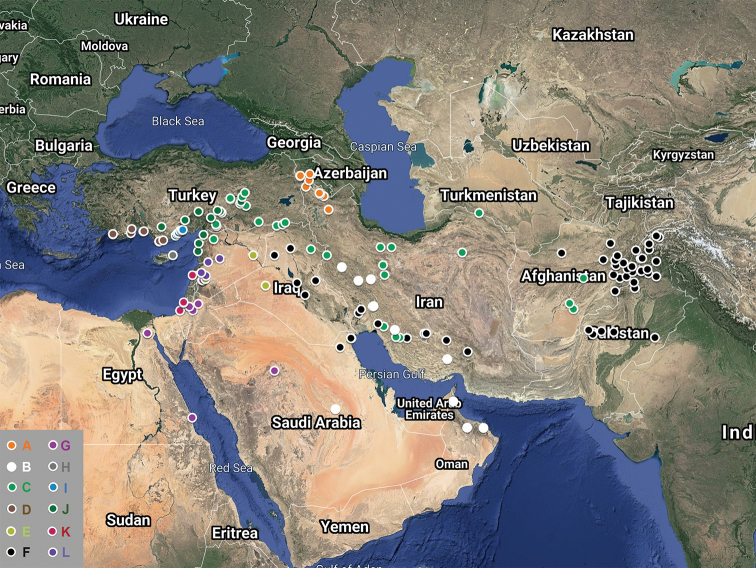
Distribution map of S.
sect.
Arenosae. Each color code corresponds to one taxon: AS.
arenosaBS.
austroiranicaCS.
chaetodontaDS.
exsudansES.
georgievskyiFS.
leyseroidesGS.
linearisHS.
microsperma
subsp.
cypriaIS.
microsperma
subsp.
maritimaJS.
microsperma
subsp.
microspermaKS.
microsperma
subsp.
modestaLS.
striata.